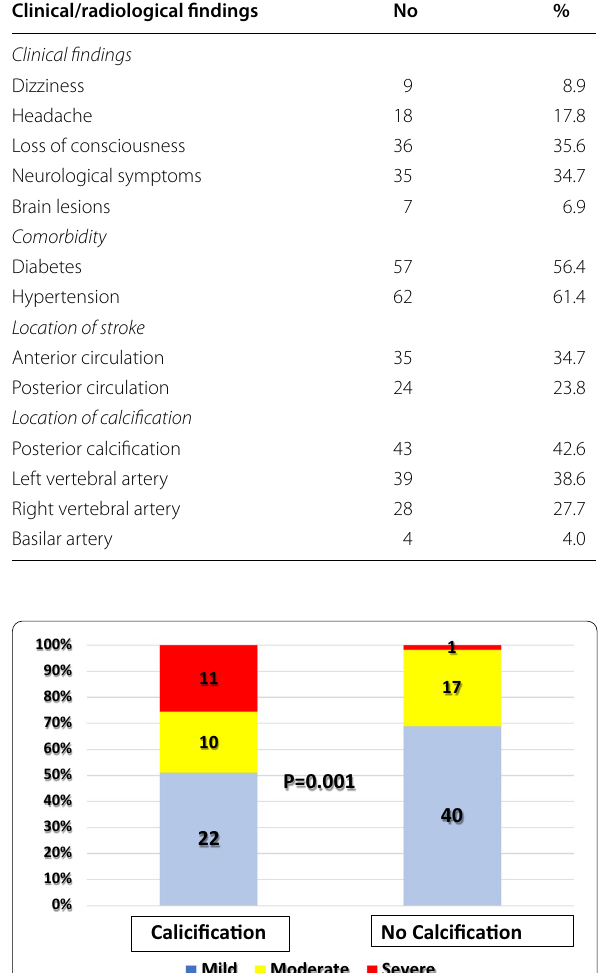
Table 1 Demographic data of patients with coronary artery calcification ( n 101) =